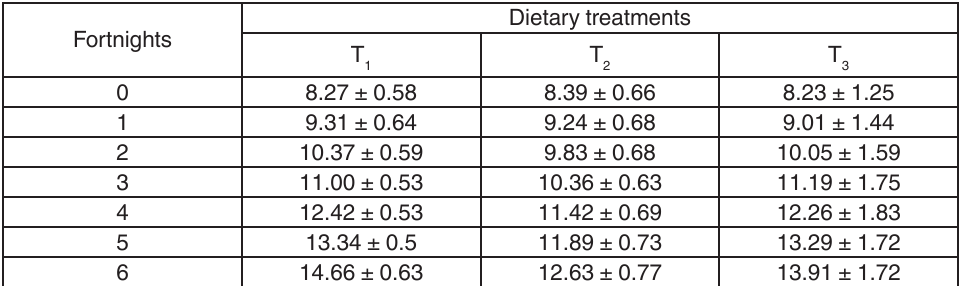
Table 4. Growth rate, feed efficiency and cost of feeding per kg gain of kids fed with ksheerabala residue